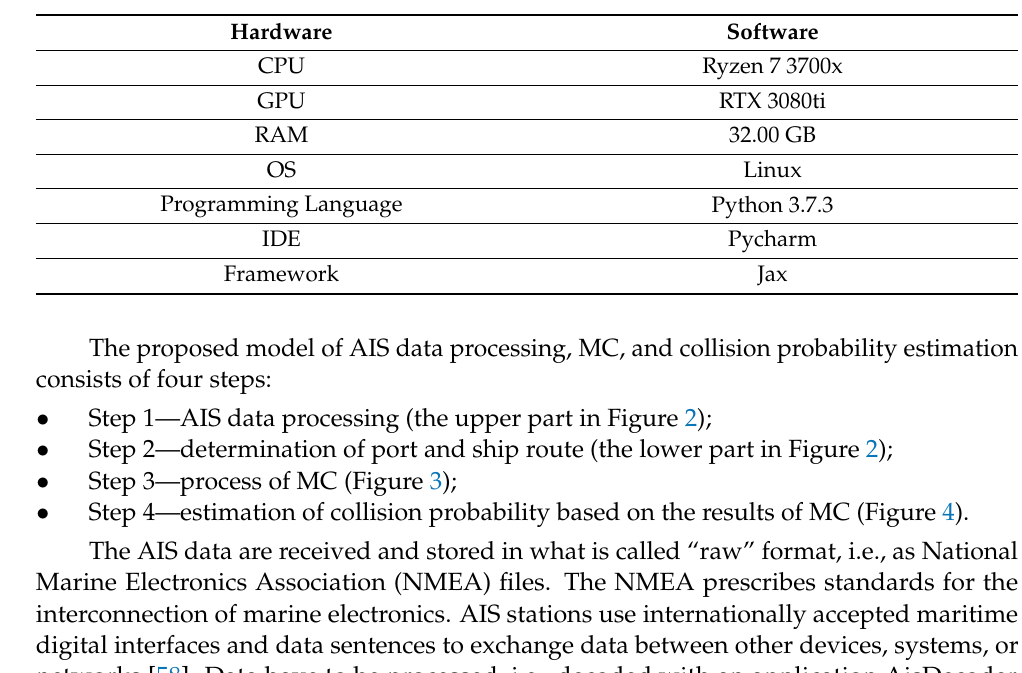
Table 1. Software and hardware